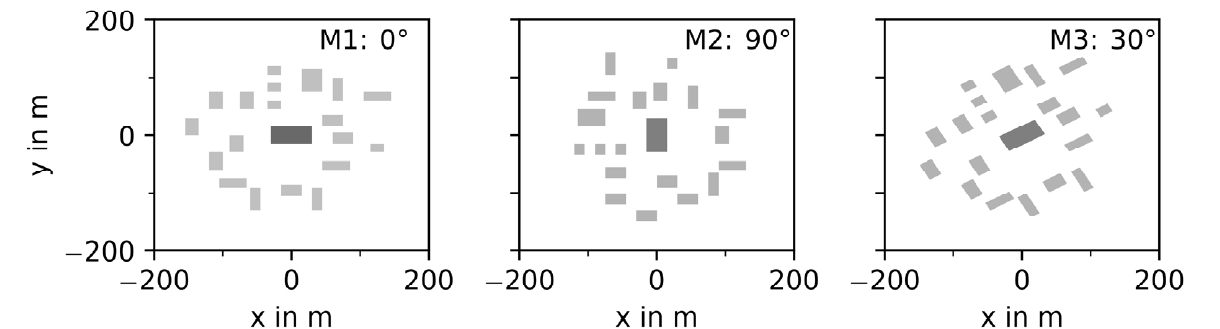
Figure 2. Building and incident flow angle configurations.